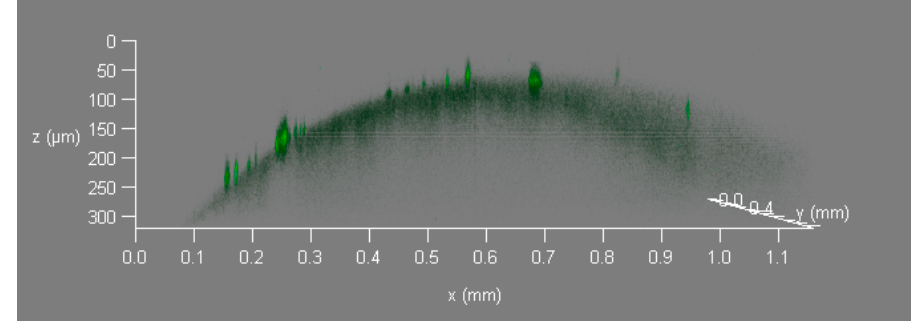
Figure 3. Laser confocal image of PLA source filament, collected from a side view with a 10× objective.